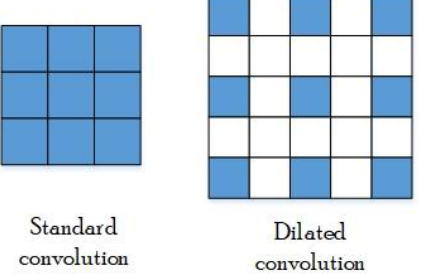
Figure 9. Schematic diagram of standard convolution and dilated convolution.